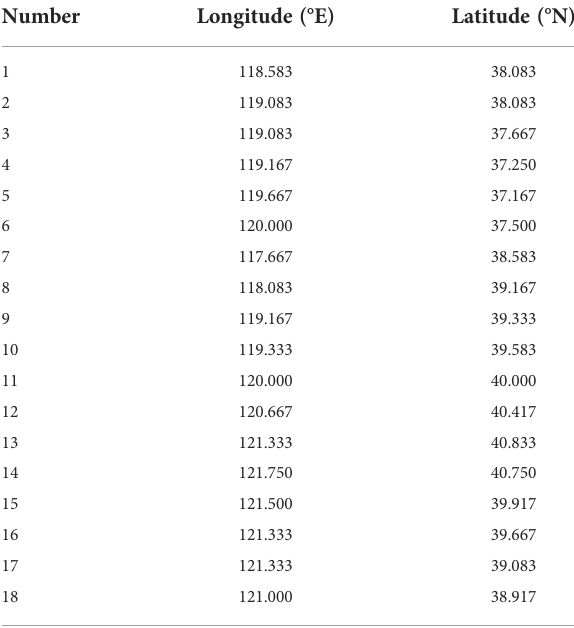
TABLE 6 Reference locations of new tidal stations based on computational